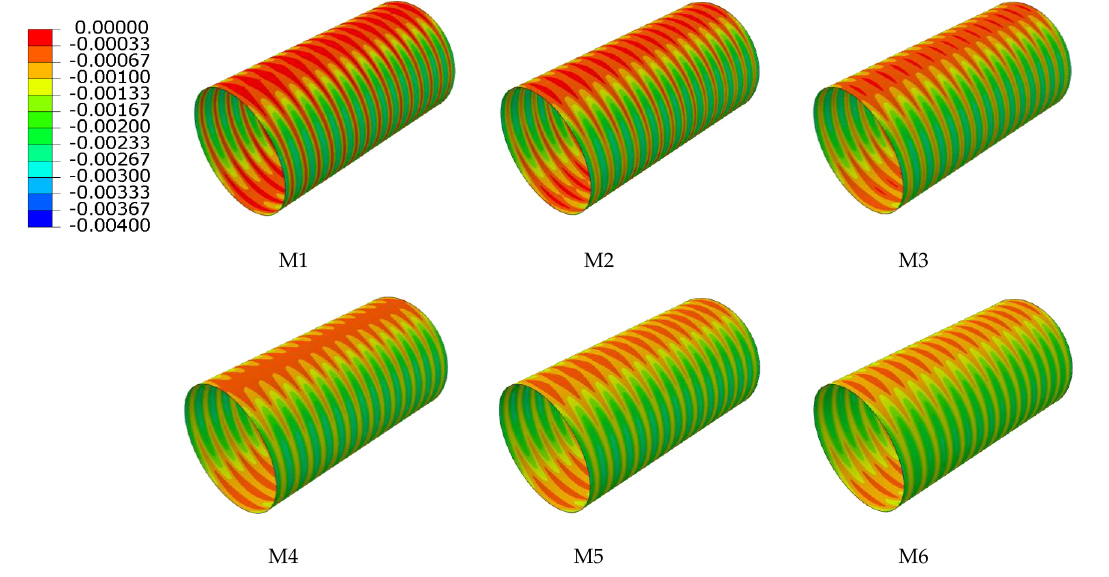
Figure 19. Circumferential strain of interior wall.